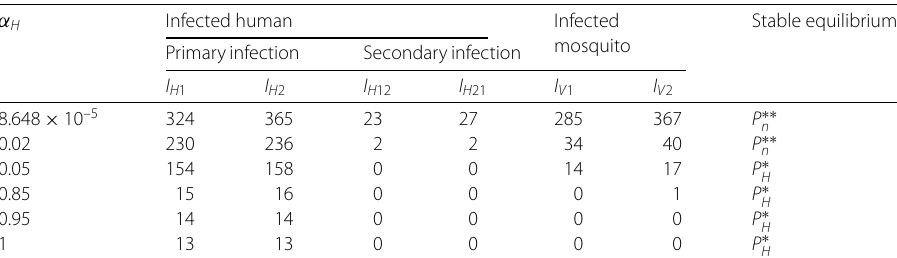
Table 4 Effect of α H on the number of infected populations: I H 1 , I H 2 , I H 12 , I H 21 , I V 1 , and I V 2 at steady state using the multi-serotype dengue model (2.4)–(2.5) α